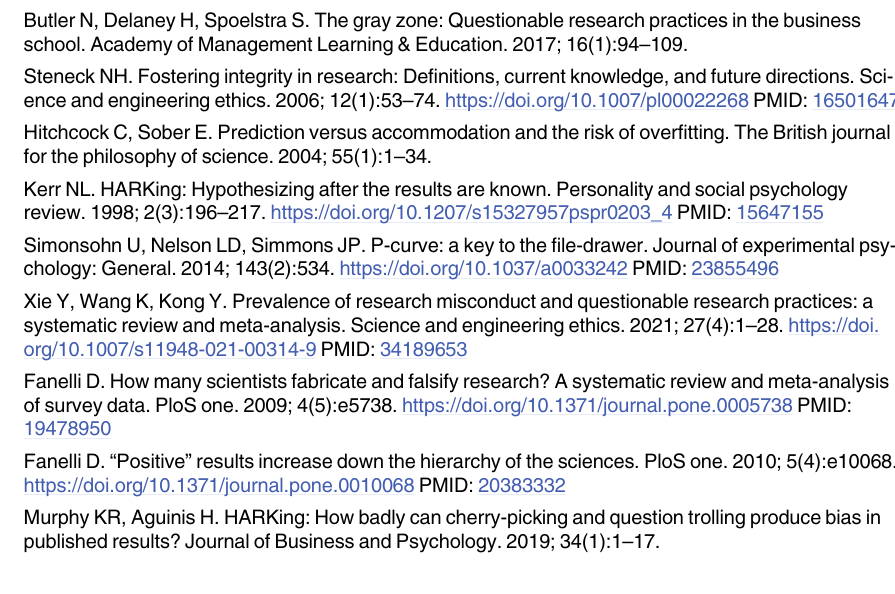
S1 Table. Multilevel logit regression results for predictors of bin membership (According to each bivariate relation